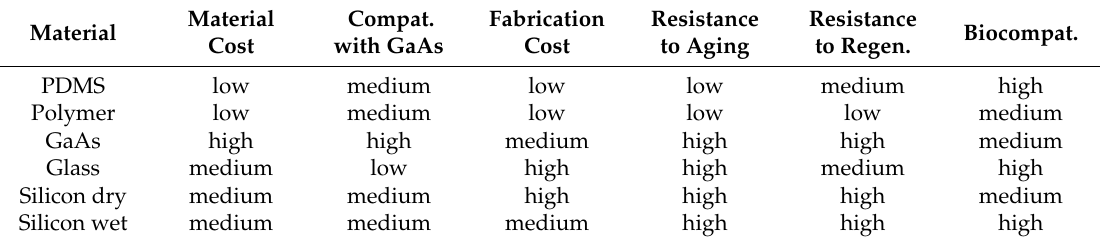
Table 1. Comparison of materials for the reusable biosensor microfluidic